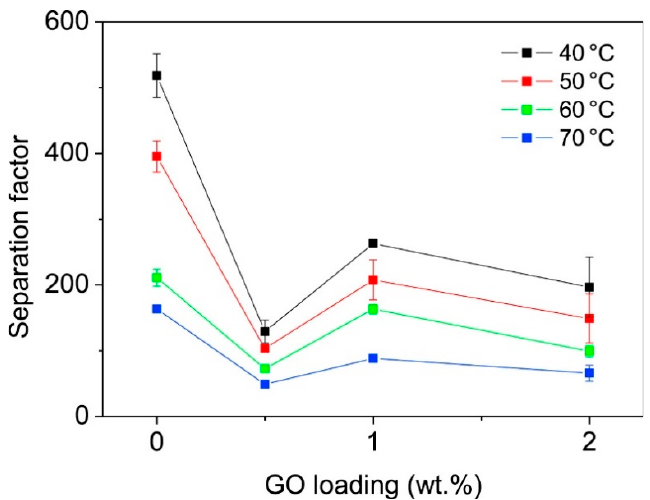
Figure 12. Cumulative permeate flux for a 10:90 wt% water-ethanol combination under various GO loading scenarios and at various operation temperatures.